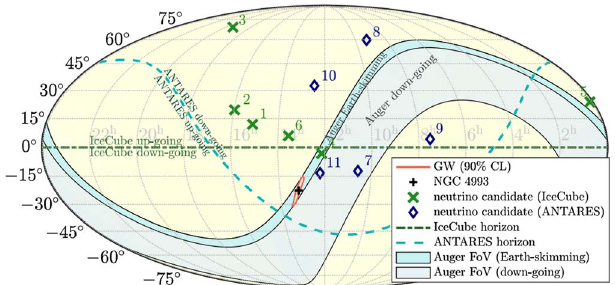
Figure 8. Skymap in equatorial coordinates during the GW170817 event. The expected localization of the BNS event and its host galaxy are shown, as well as the neutrino candidates within ±500 s of the merger and the horizons of the ANTARES and IceCube experiments. The Pierre Auger Observatory fi elds of view in the ES and DG channels are also depicted [41] and references